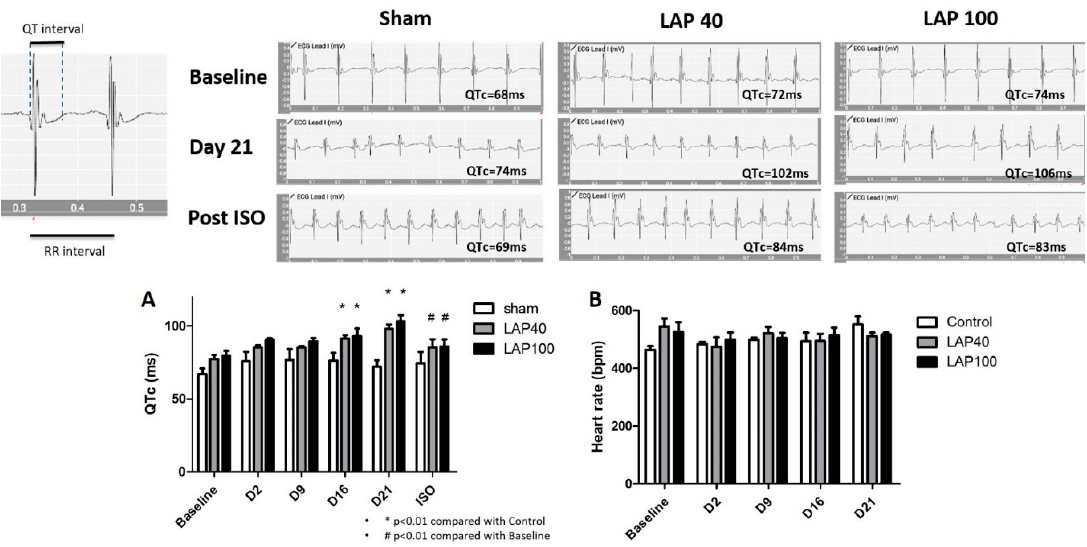
Figure 1. ( Top ) Effects of lapatinib (LAP) on QTc prolongation in the mouse model. ( A ) The changes of QTc prolongation among the sham mice and mice treated with LAP 40 mg / kg / day (LAP 40) and 100mg / kg / day (LAP 100). ( B ) The measurements of the heart rate in mice treated with LAP. * p < 0.05 by contrasts from one-way analysis of variance (ANOVA). The x -axis in the upper section is given at a standard scale in